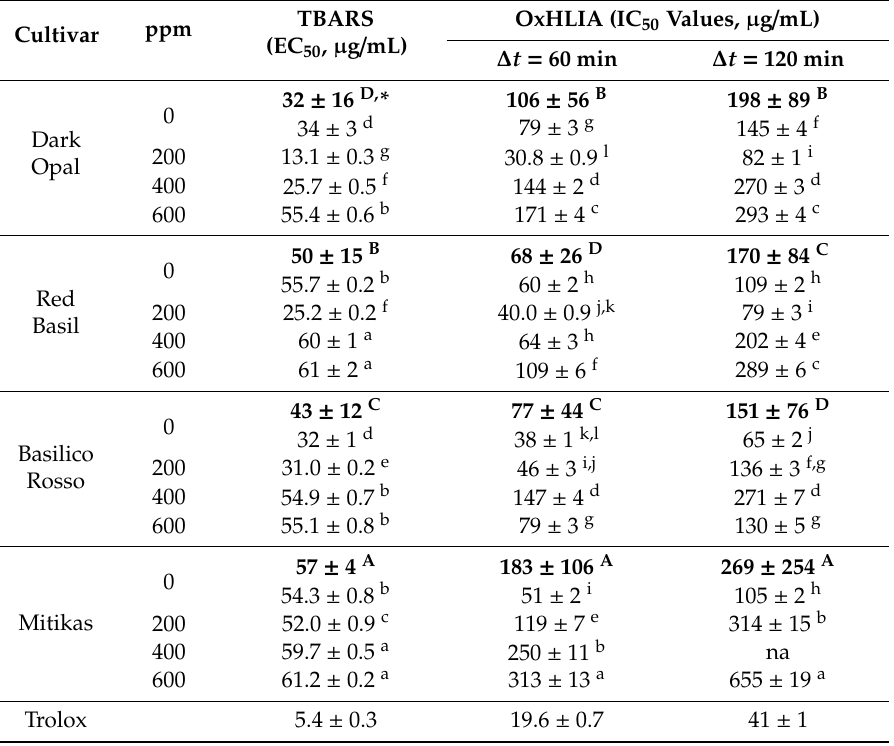
Table 6. Antioxidant activity of the leaves’ hydroethanolic extracts of the studied basil genotypes in relation to nitrogen input (mean ± SD, n =